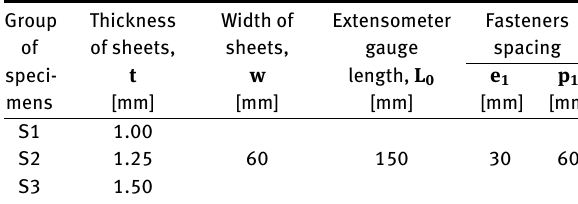
Table 1: Dimension of test specimens